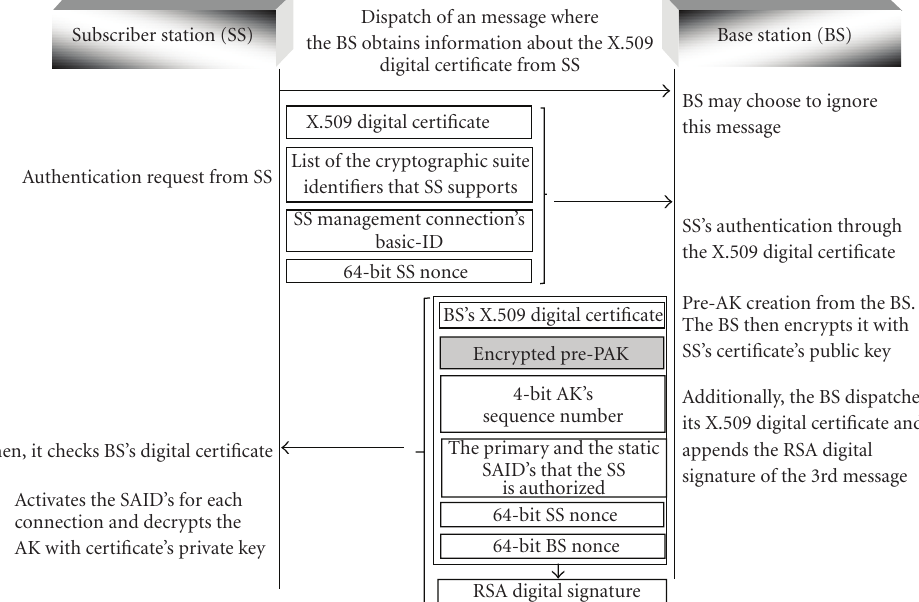
Figure 12: 802.16e Authentication Process with PKM v.2.